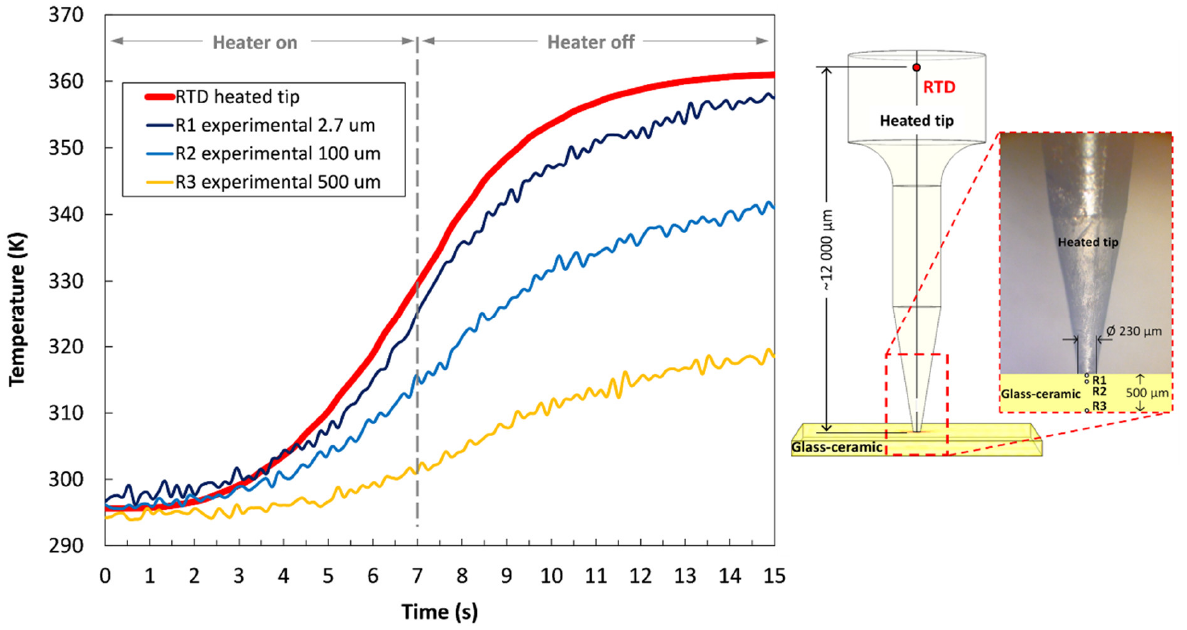
Figure 4. Temperature profiles measured at different axial planes within the transparent fluorescent sample during one heating cycle ( left ) using a heating tip ( right ).